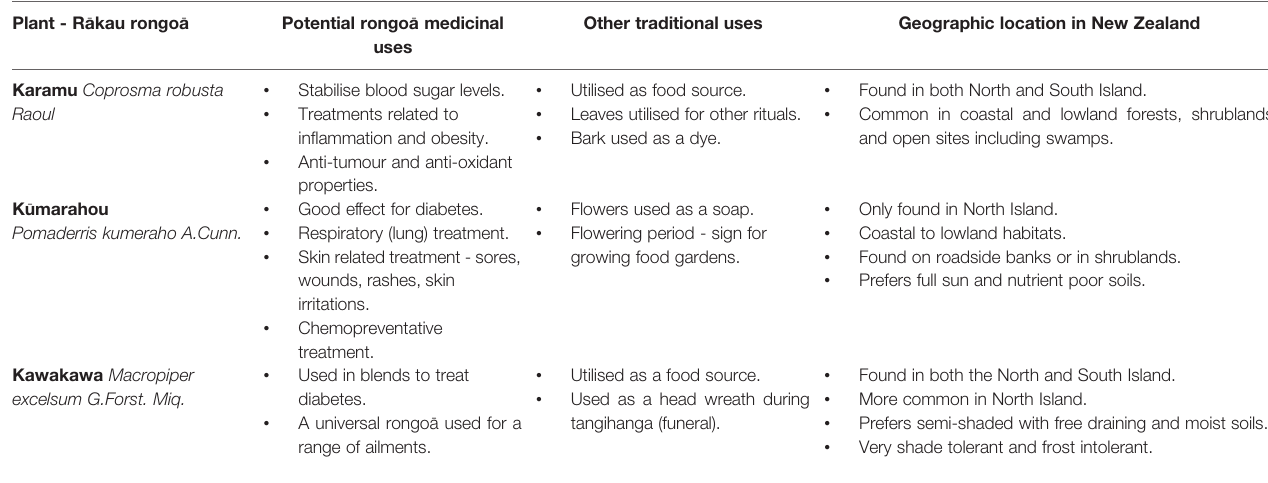
TABLE 1 | Anti-diabetic ra ̄ kau rongoa ̄ with potential rongoa ̄ medicinal uses, other traditional uses and geographic location in New Zealand. Plant - Ra ̄ kau rongoa